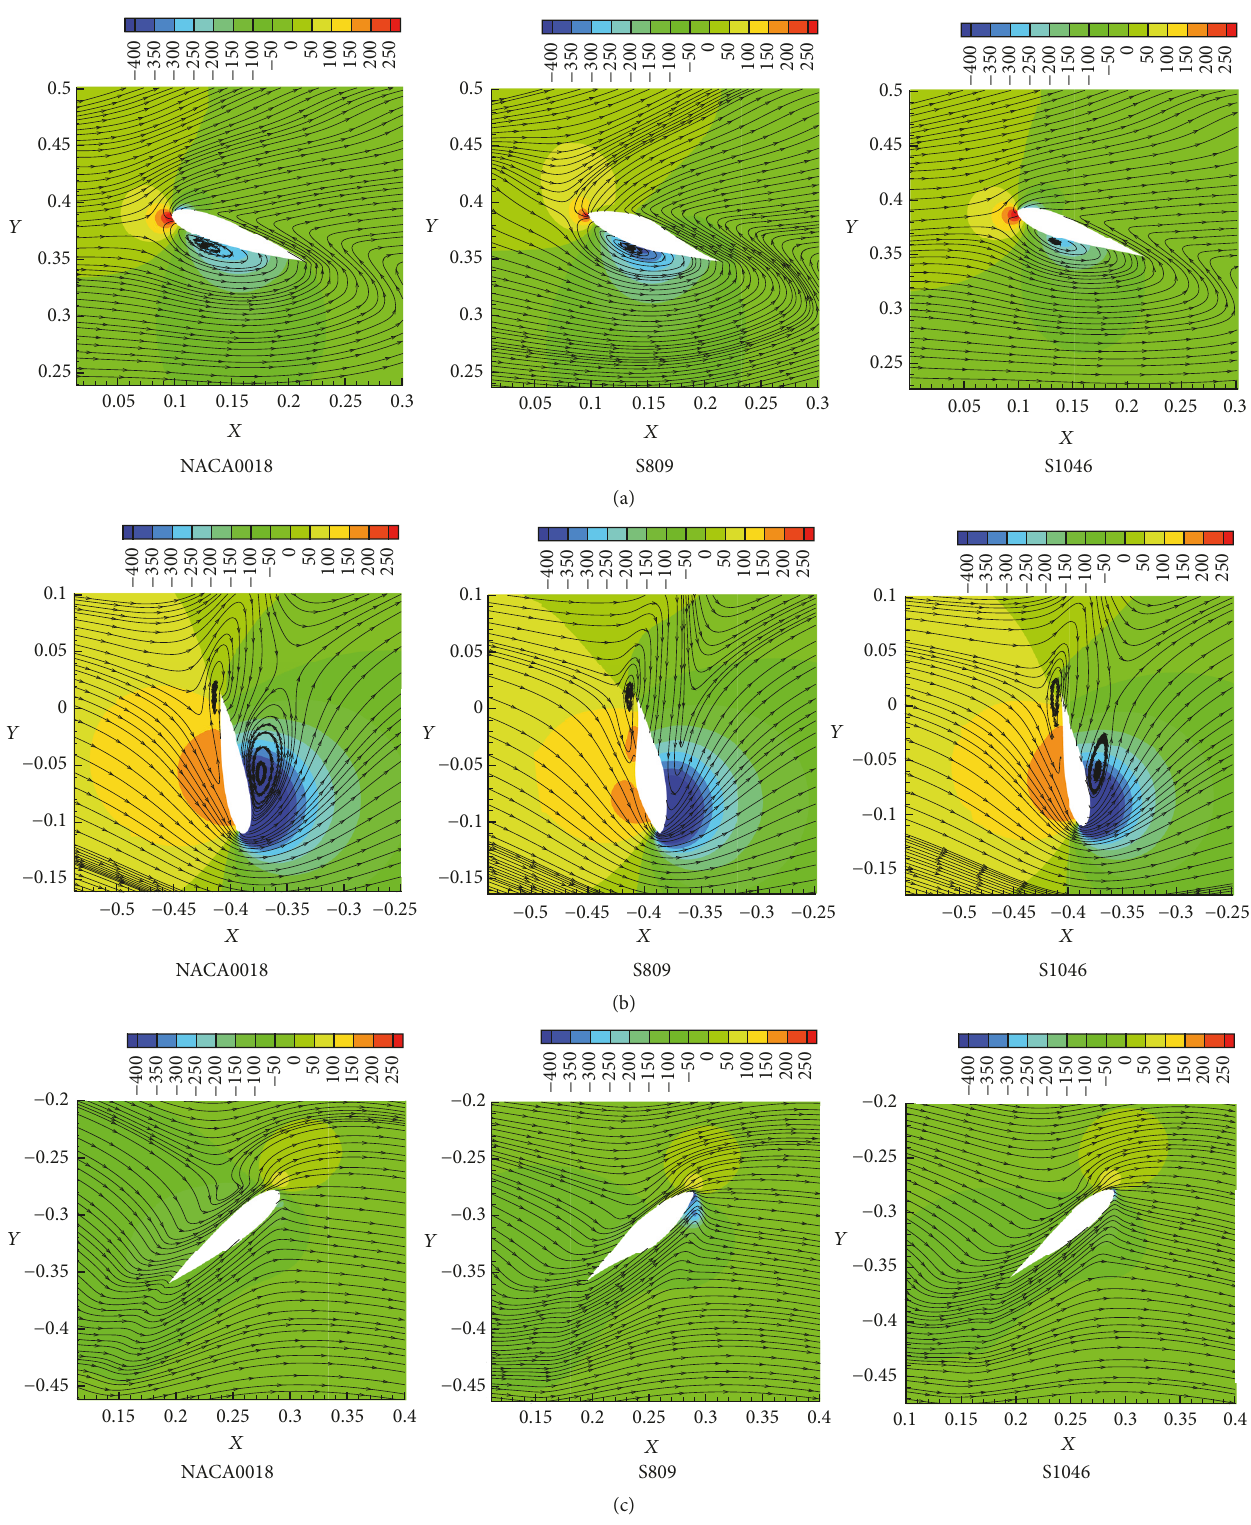
Figure 12: Flow fields around blade with different airfoils ( 𝜃 = 100 ∘